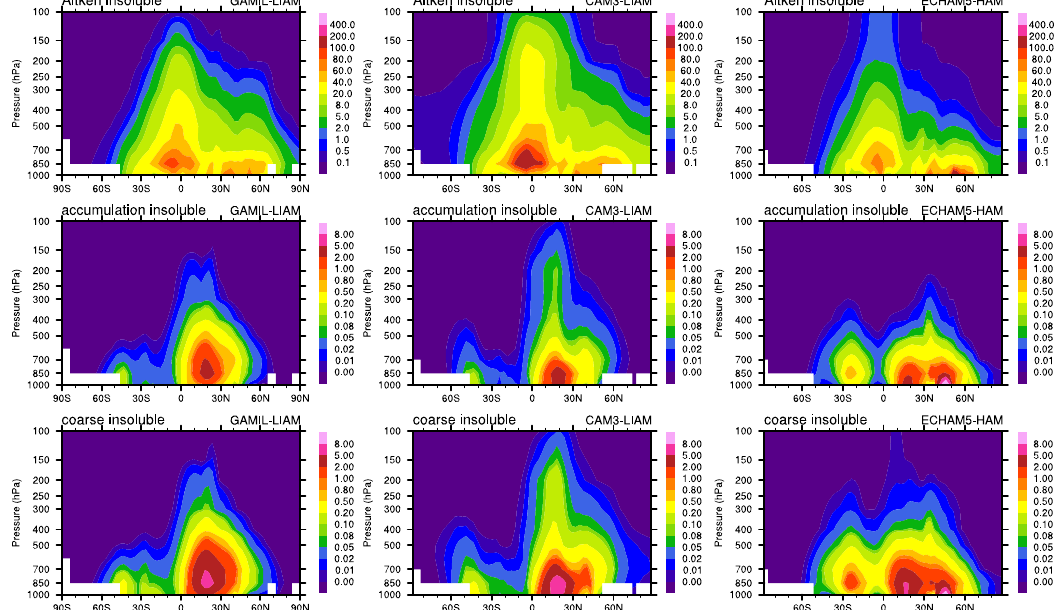
Fig. 6. Zonal and annual mean aerosol number concentration of the three insoluble modes (from top to bottom) simulated by GAMIL-LIAM (left column), CAM3-LIAM (middle column) and ECHAM5-HAM (right column). The unit is number of particles per cubic centimeter at the standard atmospheric state (1013.25hPa, 273.15K).